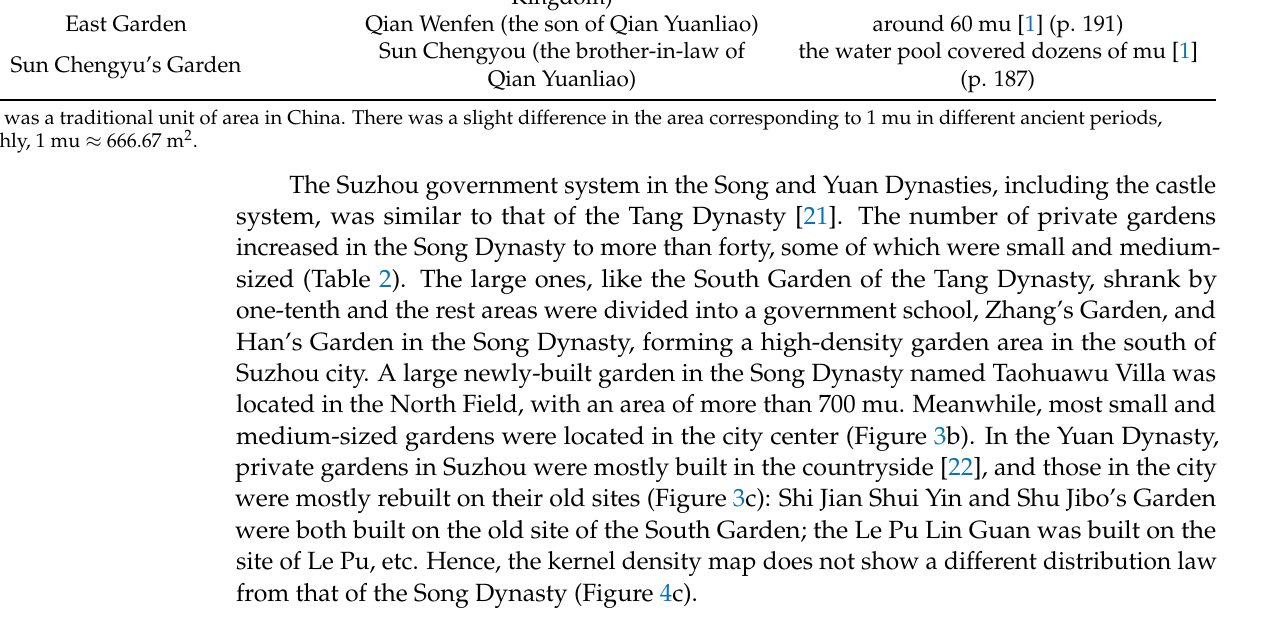
Table 2. Recorded scales of Suzhou private gardens in the Song